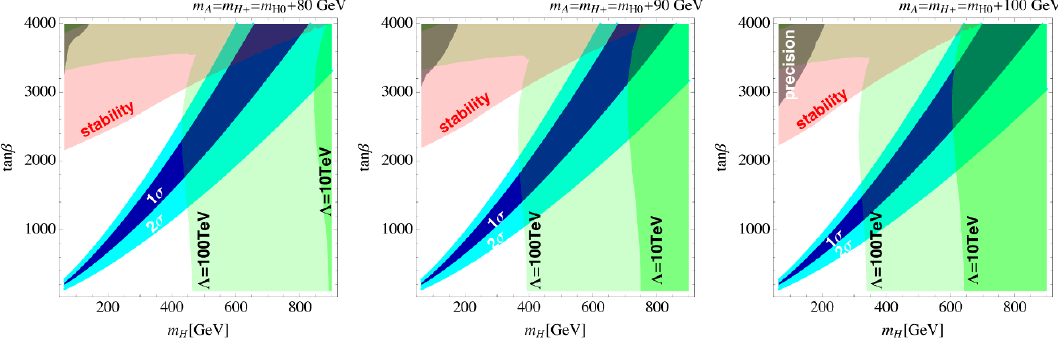
Figure 1 . Regions where the prediction for the muon g (cid:0) 2 is consistent with the measurement within 1 (cid:27) (blue) and 2 (cid:27) (cyan). The green (darker green) region shows the cuto(cid:11) scale to be less than 100 (10) TeV given by the perturbative unitarity bound (see section 3.2). The red region indicates the cuto(cid:11) scale to be less than 10 TeV given by the vacuum stability bound (see section 3.2). The gray region is excluded by the electroweak precision measurements at 95% CL (see section